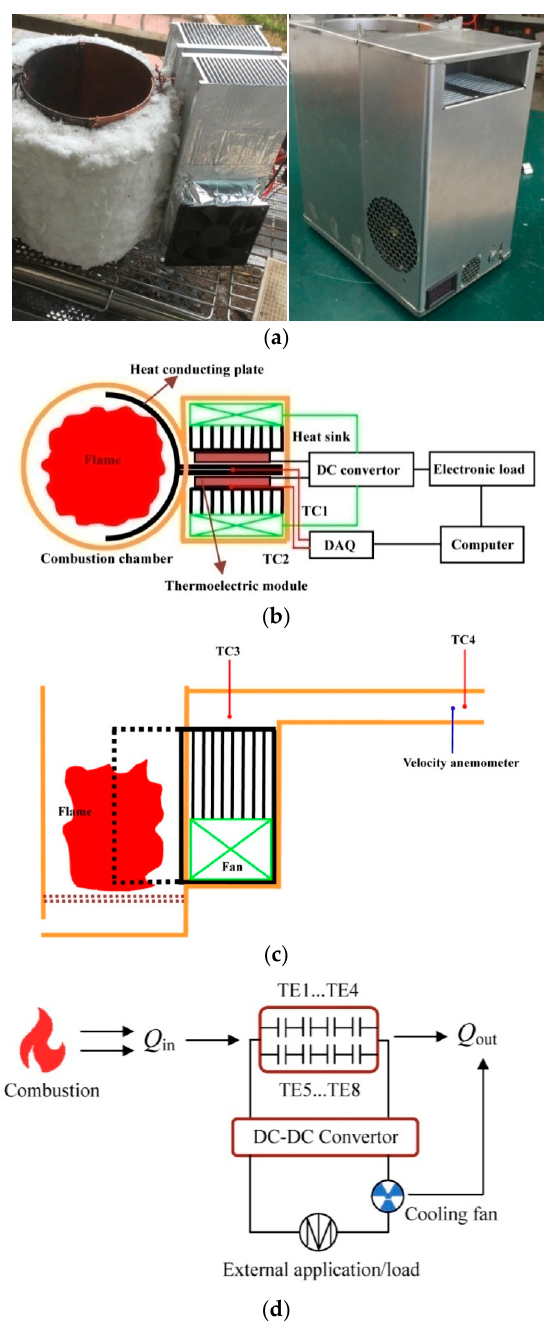
Figure 2. The STEG photographs, the experimental setup and the electric circuit ( a ) photographs; left: STEG core, right: a pilot product; ( b ) a sketch of the experimental setup (top view); ( c ) a sketch of the experimental setup (side view); ( d ) schematic drawing of the electric circuit with multiple TE modules fitted.